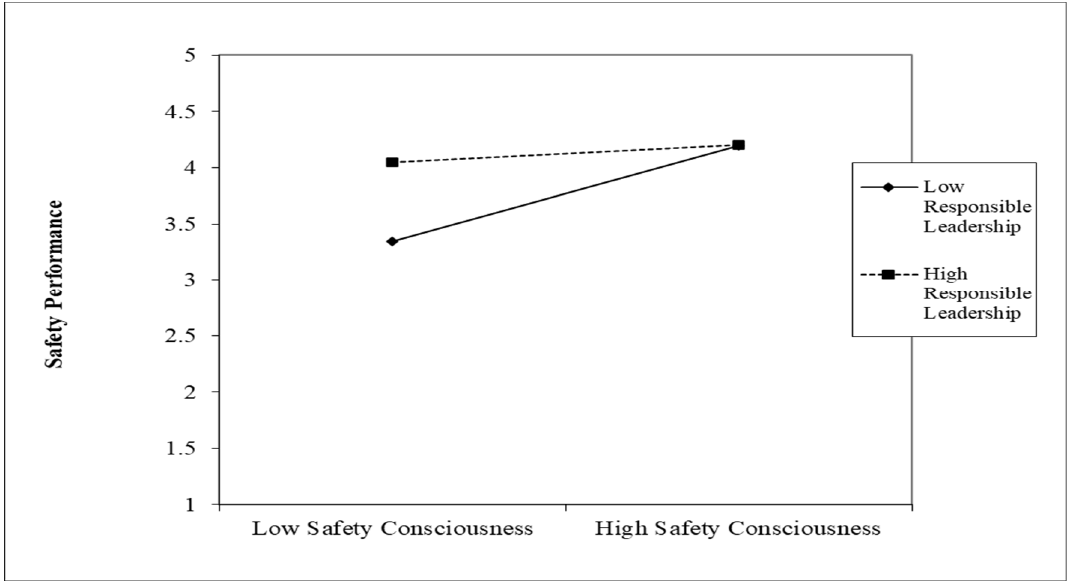
Figure 2. Interaction plot for responsible leadership and safety consciousness.